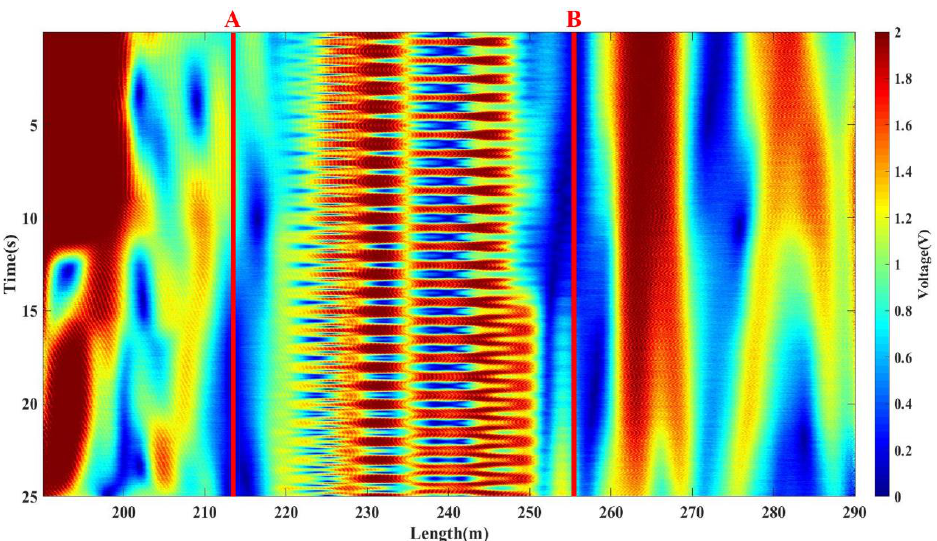
Figure 7. Amplitude of vibration. A and B represent fading